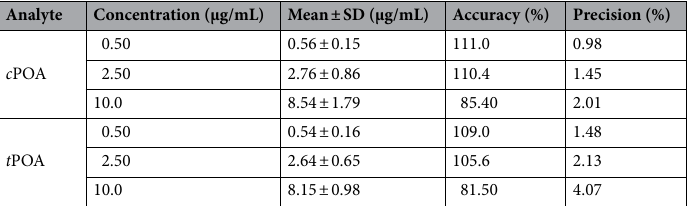
Table 2. Accuracy and precision for determination of c POA and t POA in serum samples (n = 6).